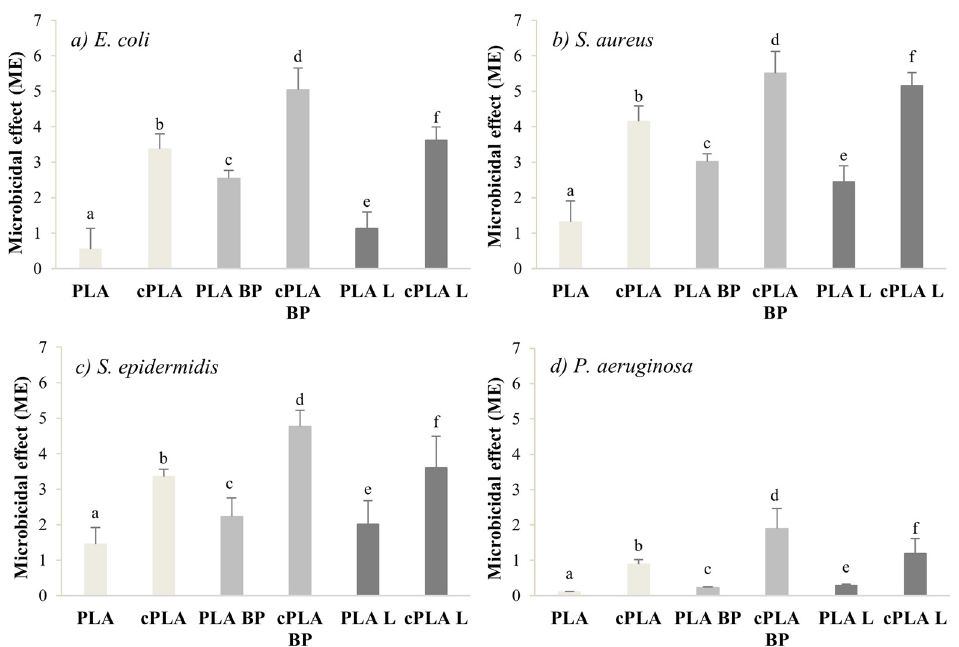
Figure 7. Microbicide effect (ME) of coated and uncoated fibres after 24h incubation with E. coli ( a ), S. Aureus ( b ), S. Epidermidis ( c ) and P. Aeruginosa ( d ) (mean values ± s.d.; n = 3). ( a ) ANOVA one-way ( p < 0.05), Multiple Range Test: a vs. b, c; b vs. d; c vs. d, e; d vs. f; e vs. f. ( b ) ANOVA one-way ( p < 0.05), Multiple Range Test: a vs. b, c; b vs. d; c vs. d; e vs. f. ( c ) ANOVA one-way ( p < 0.05), Multiple Range Test: a vs. b; b vs. d; c vs. d; e vs. f. ( d ) ANOVA one-way ( p < 0.05), Multiple Range Test: a vs. b; b vs. d; c vs. d; e vs. f.